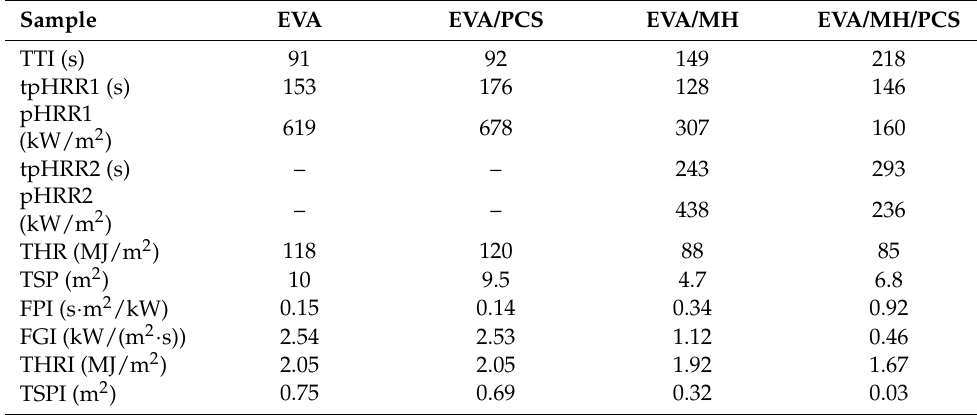
Table 1. The combustion parameters of EVA and its